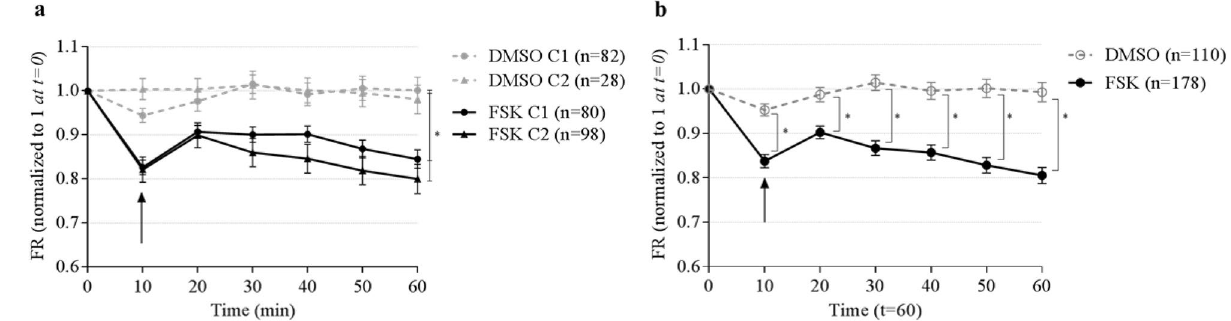
Figure 1. Similar responses of WT nasospheroids using two conditions of exposure to Matrigel and differences between incubation with FSK or DMSO . ( a ) Nasospheroids from seven WT patients were grown in two conditions: the standard protocol or condition 1 (C1) (spheres formed in suspension and embedded in Matrigel the day before live-cell imaging) and condition 2 (C2) (spheres in Matrigel for 7 days minimum) (see details in Methods ). The starting size of each nasospheroid was set at 1. At time point 0, nasopheroids were in basal conditions. For CFTR activation ( FSK ), 10 µM forskolin plus IBMX and amiloride (for epithelial sodium channel “ENaC” inhibition) were incubated (t = 10; black arrow). For non-stimulated spheres, dimethyl sulfoxide ( DMSO ) was administered. Size reduction in respect to basal size was calculated along time points up to 60 min. No significant differences were found between conditions 1 and 2 (“FSK” incubation or non- stimulated “DMSO”) (* p = 0.1563; paired t-test). Dots and triangles represent the mean fractional reduction (FR) at each time point. Bars represent standard deviation error (SEM). ( b ) Results from spheres grown under conditions 1 and 2 were combined. Differences between stimulus DMSO and FSK were observed from t = 10 and increased over time (t-test by GraphPad Prism and by our newly developed logarithmic-transformed measures’ model) (t = 10 min p = 0.008, t = 35 min p = 0.0.0004, t = 70 min p = 0.0002). We also observed a reduction peak when DMSO or FSK were added at time 10 (black arrow). This change could be due to a reaction of nasospheroids to the addition of compounds. Bars represent standard deviation error (SEM). Graphic created with GraphPad Prism version 6 33